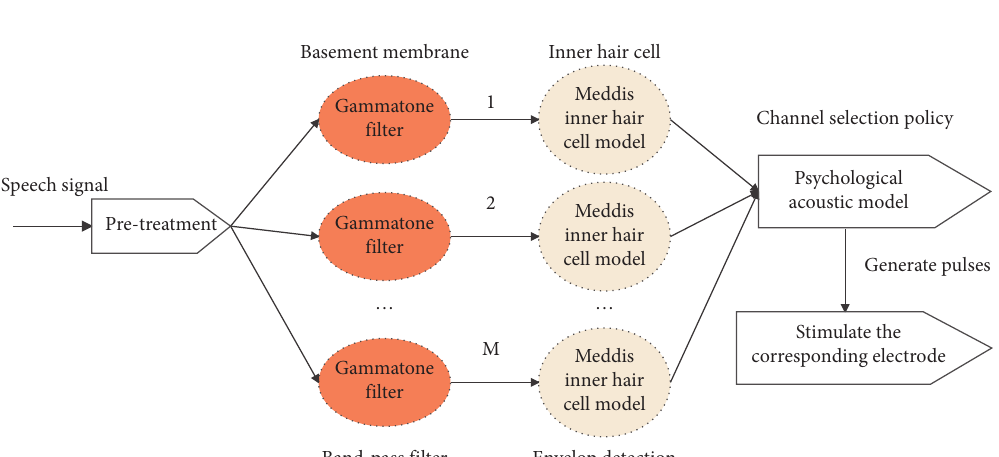
Figure 8: Psychoacoustic masking model.